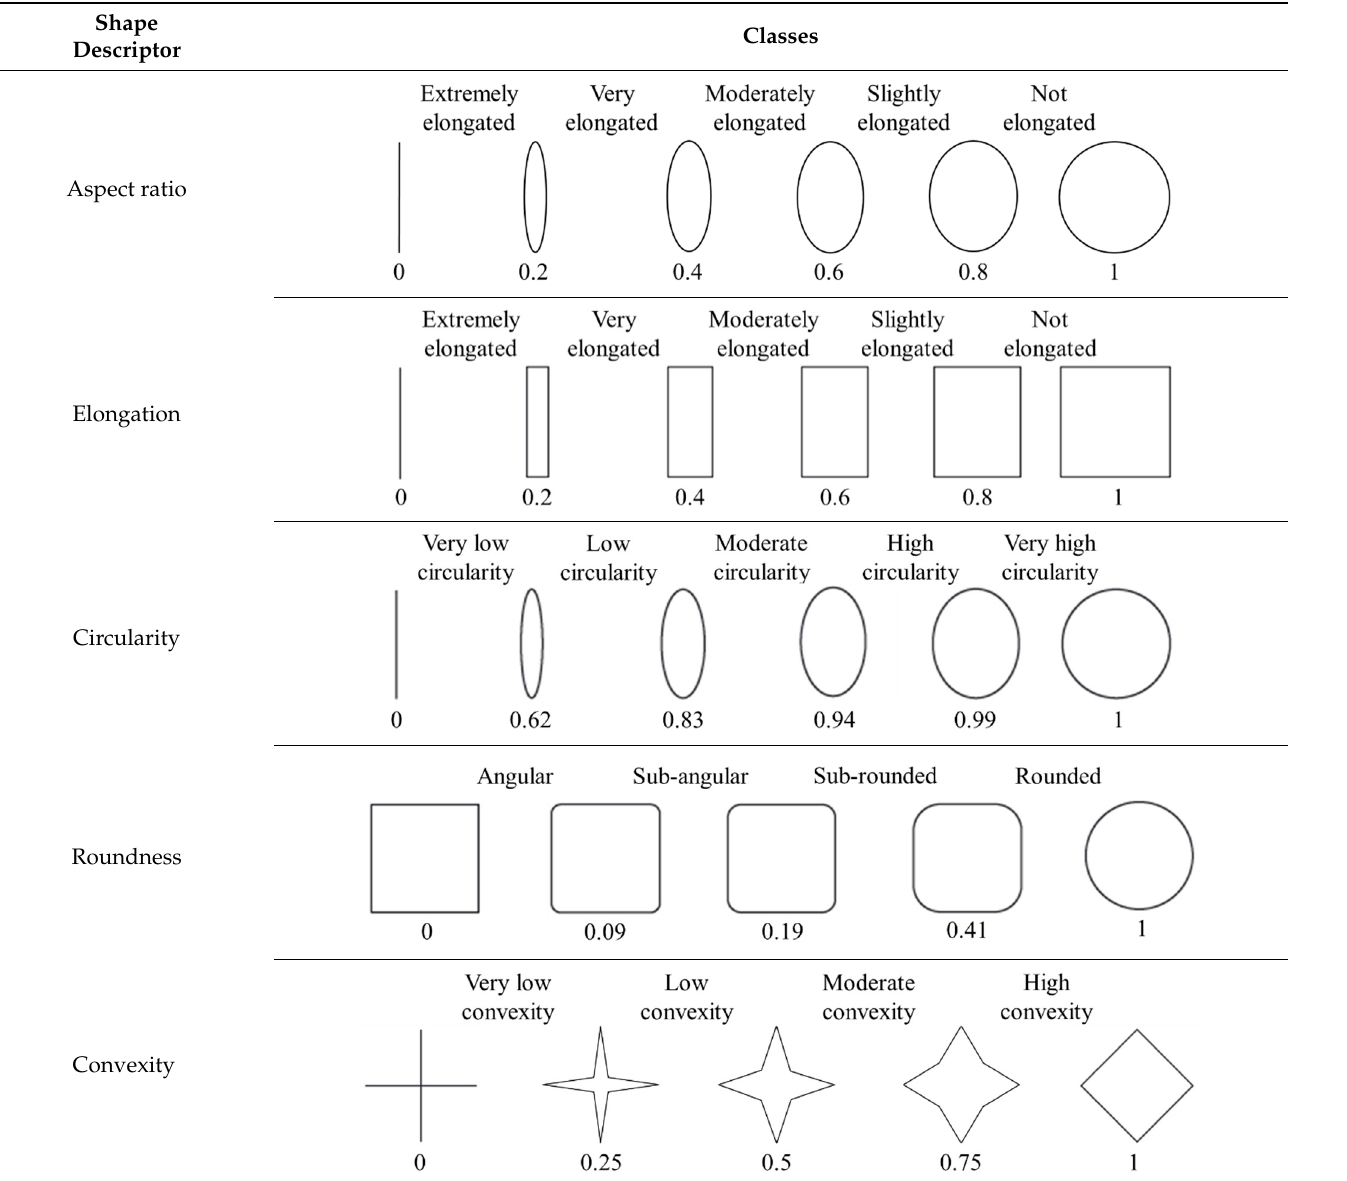
Table 2. Classification used for shape descriptors and illustrations.